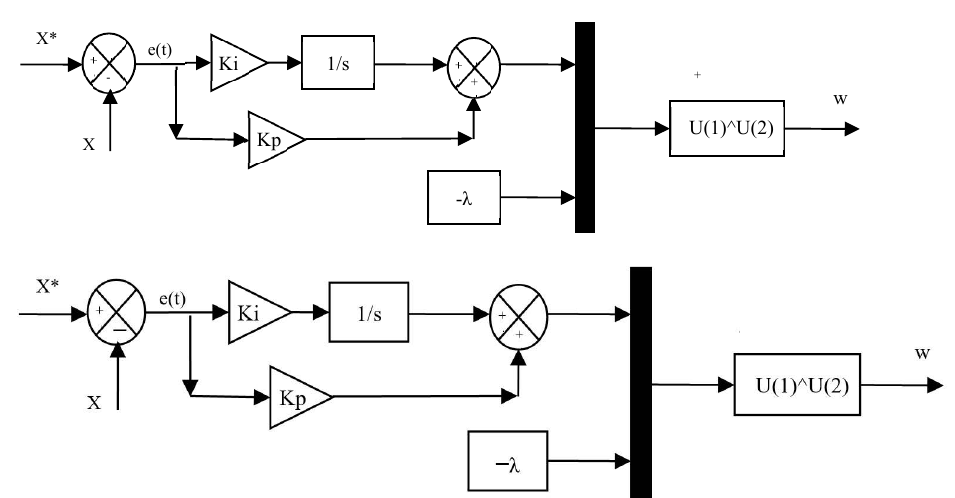
Figure 11. Proposed FOPI controller.